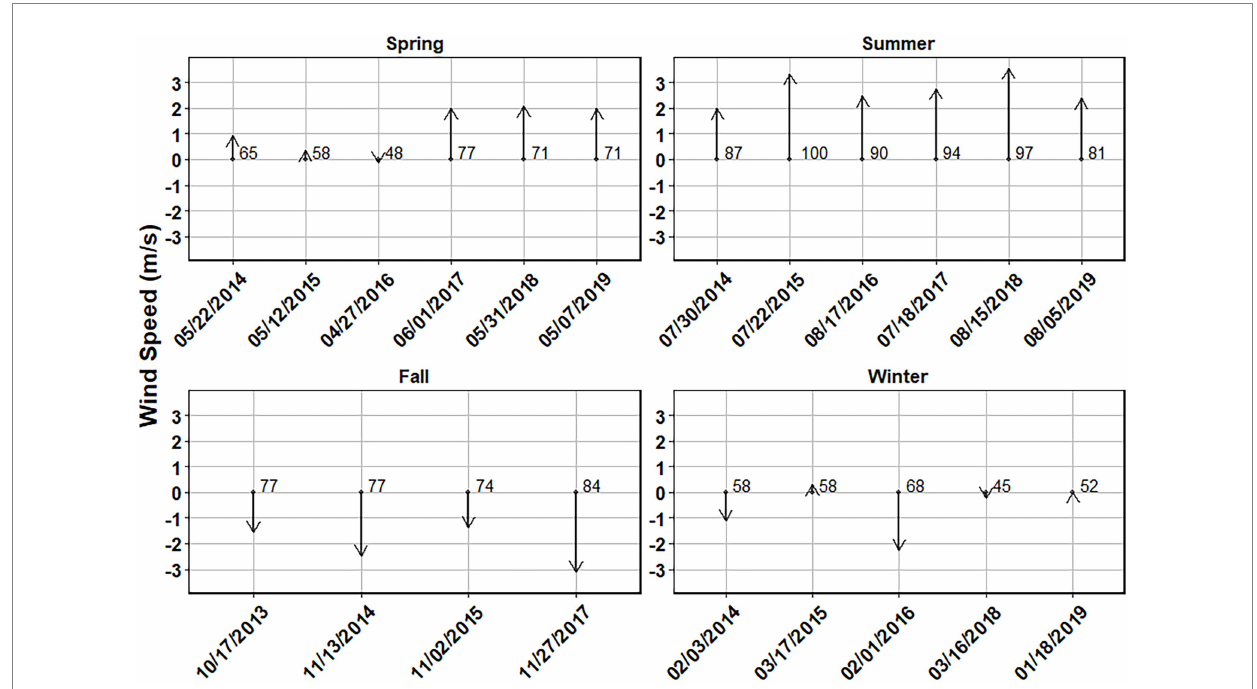
FIGURE 6 Average vertical wind speed (m/s) over a 30-day period prior to the sampling date for each season. Positive values represent wind traveling from south to north. Numbers to the right of the vector arrows represent the percentage of days where the average wind was traveling in the direction of the